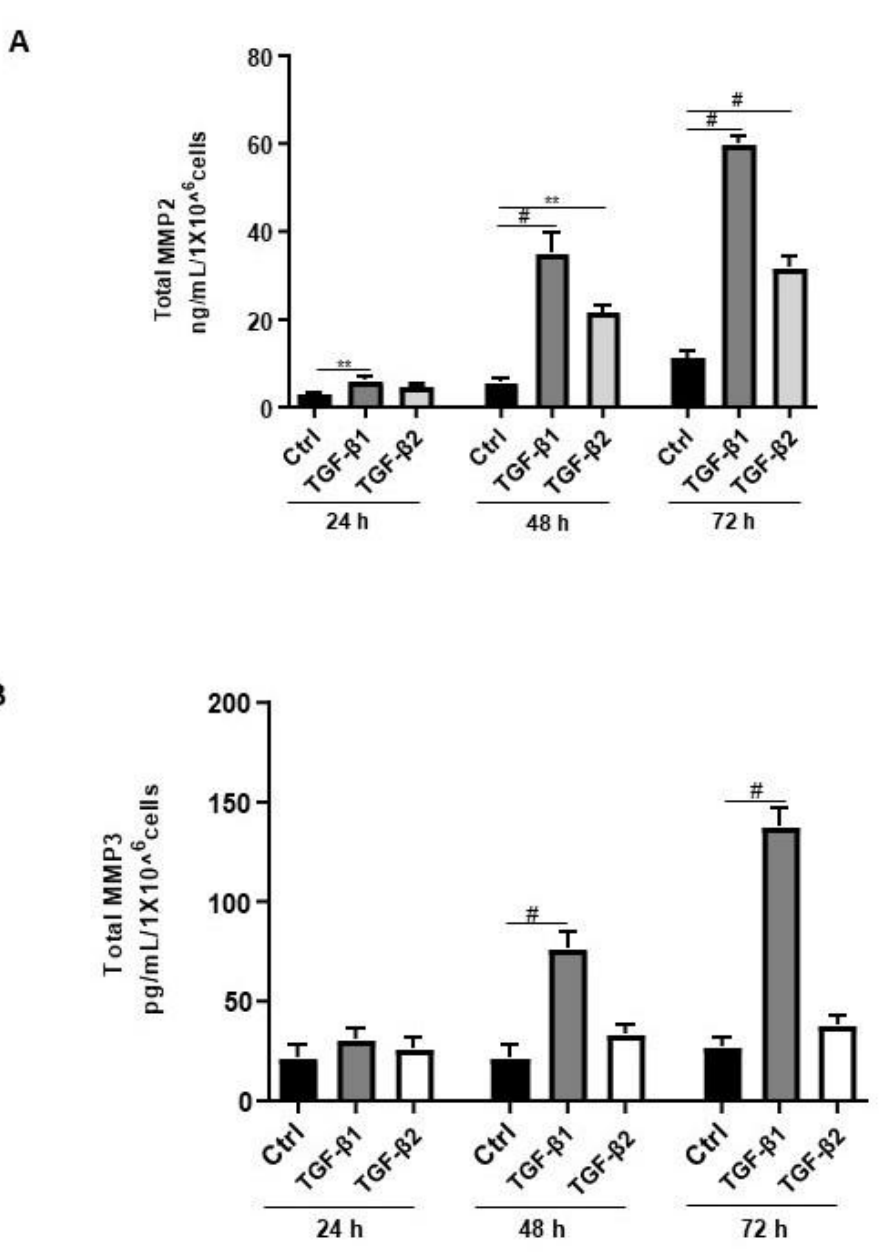
Figure 6. Time-dependent effects of TGF- β 1 and TGF- β 2 treatment on MMP2 and MMP3 secretion. Epithelial 12Z cells were stimulated with TGF- β 1 or TGF- β 2 (10 ng/mL) for 24, 48, and 72 h, and supernatants were analyzed by MMP2 ( A ) and MMP3 ( B ) ELISAs. Both TGF- β 1 and - β 2 stimulation of the epithelial cells significantly enhanced MMP2 secretion in a time-dependent